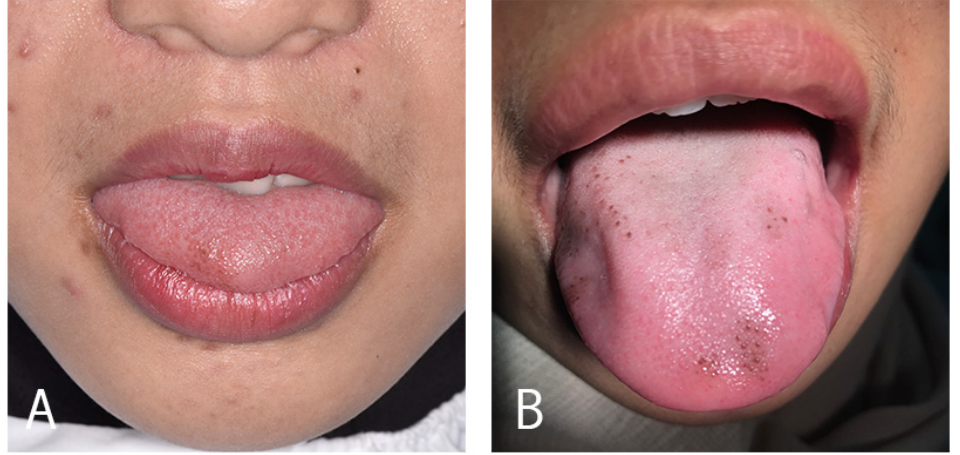
Figure 1. Clinical appearance of PFP, showing the Holzwanger Type 1 ( A ) and Type 2 ( B )